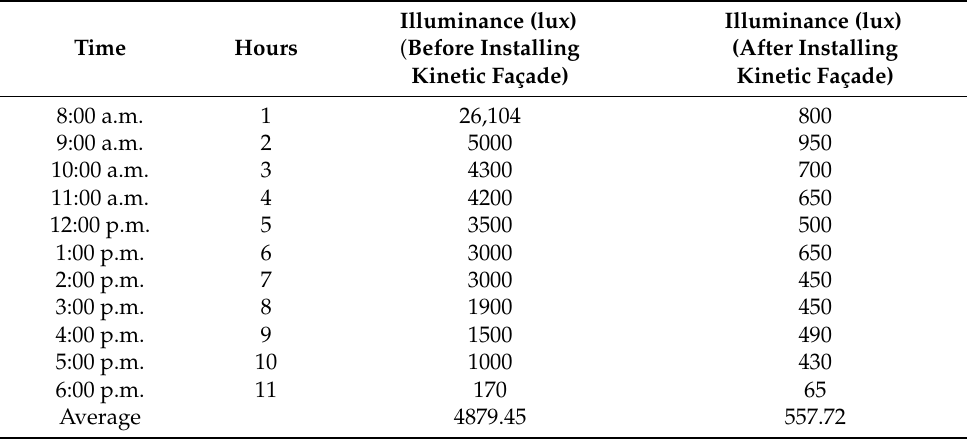
Figure 19. Testing in the actual situation, comparing graph trends between before and after installa- tion of the kinetic façade (version 2: twisting movement). Table 4. Comparing approximate lux value trends between before and after installation of the kinetic façade (version 2: twisting